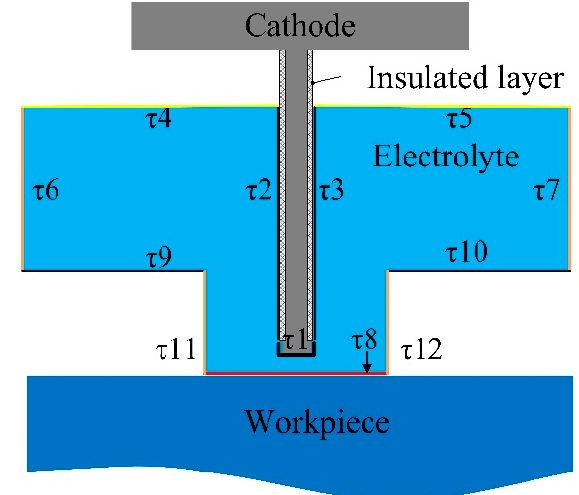
Figure 5. Boundary distribution in simulation.